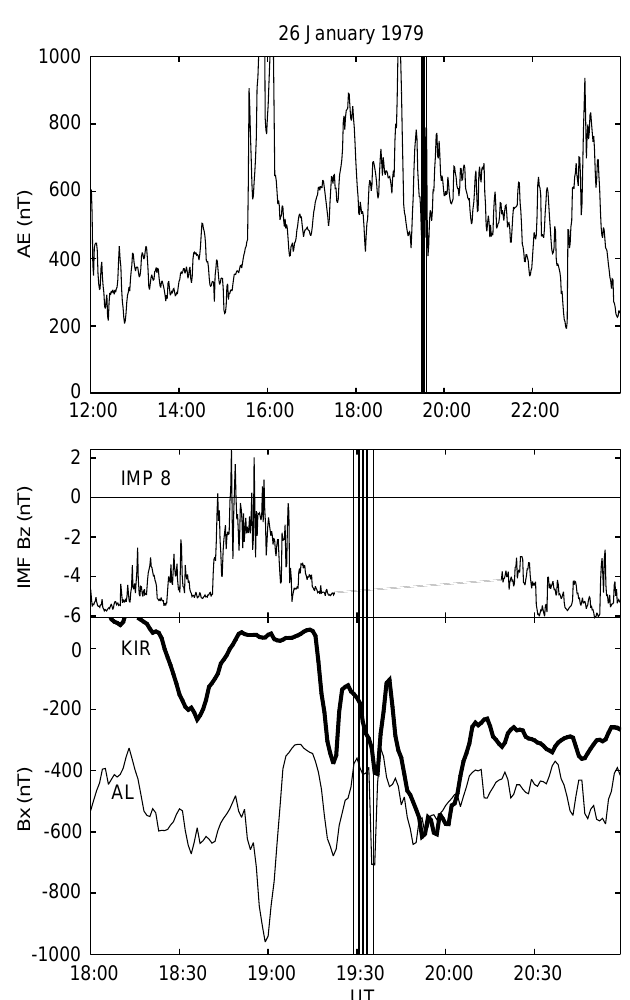
Fig. 2. Fading event on 26 January 1979: ( top panel ) AE index before and after the fading times, ( middle panel ) IMF B z in GSM coordinates recorded by IMP-8 (satellite location: X GSM from 4.2 to 5 : 9 R E , Y GSM from (cid:255) 38 : 2 to (cid:255) 37 : 7 R E , and Z GSM from 3.9 to (cid:255) 1 : 8 R E ), and ( bottom panel ) AL index ( thin line ) together with the local B x magnetogram at KIR ( heavy line ). The vertical lines mark the fading and